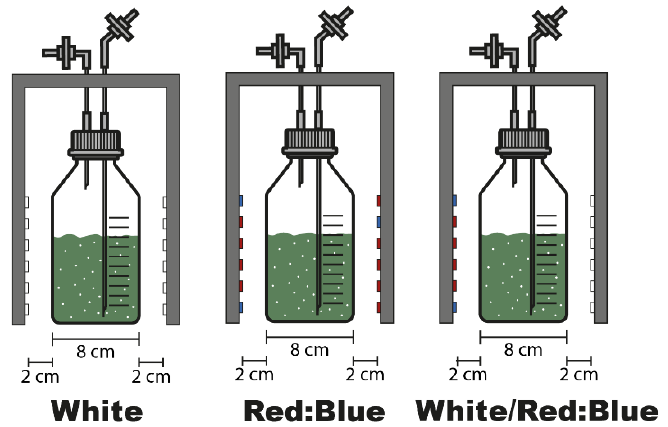
Figure 1. Cultivation system